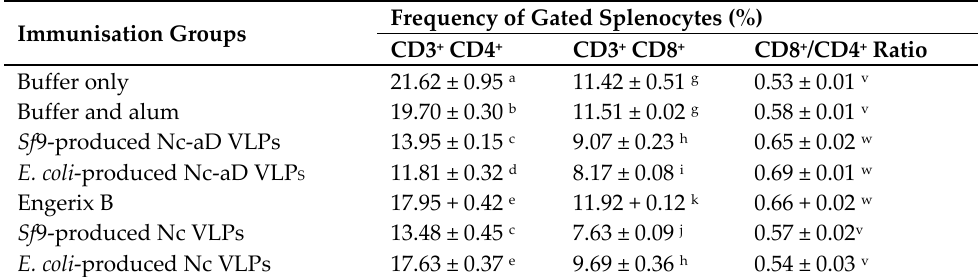
Table 1. T lymphocyte populations in mouse splenocytes .